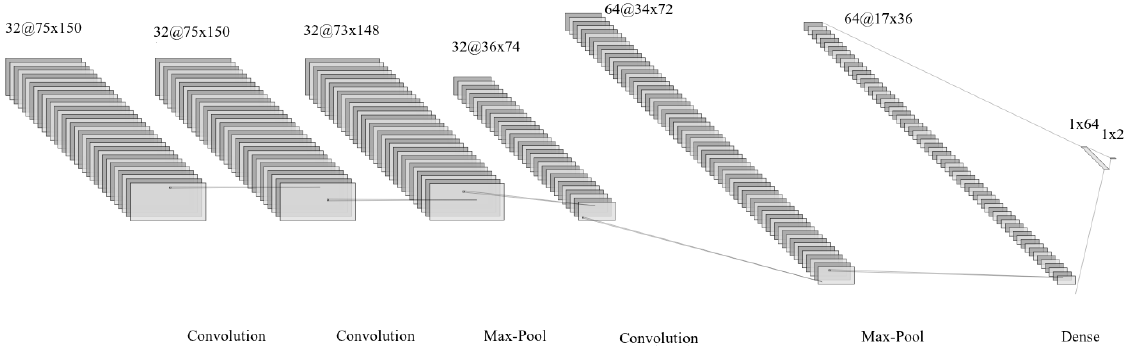
Figure 4. Architecture of the CNN | 2 model is shown. It uses the same loss function and optimizer as Scratch the CNN | 1 model. In both of the models, we have used dropout layers with 0.5 dropout and ‘Relu’ as Scratch the activation function based on empirical